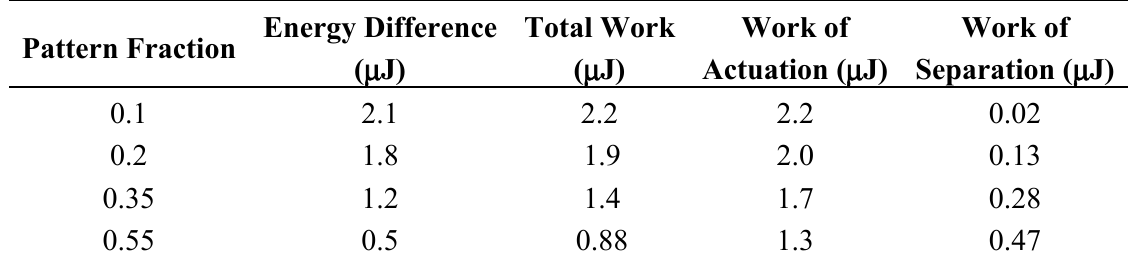
Table 1. The total operation work with different pattern areal